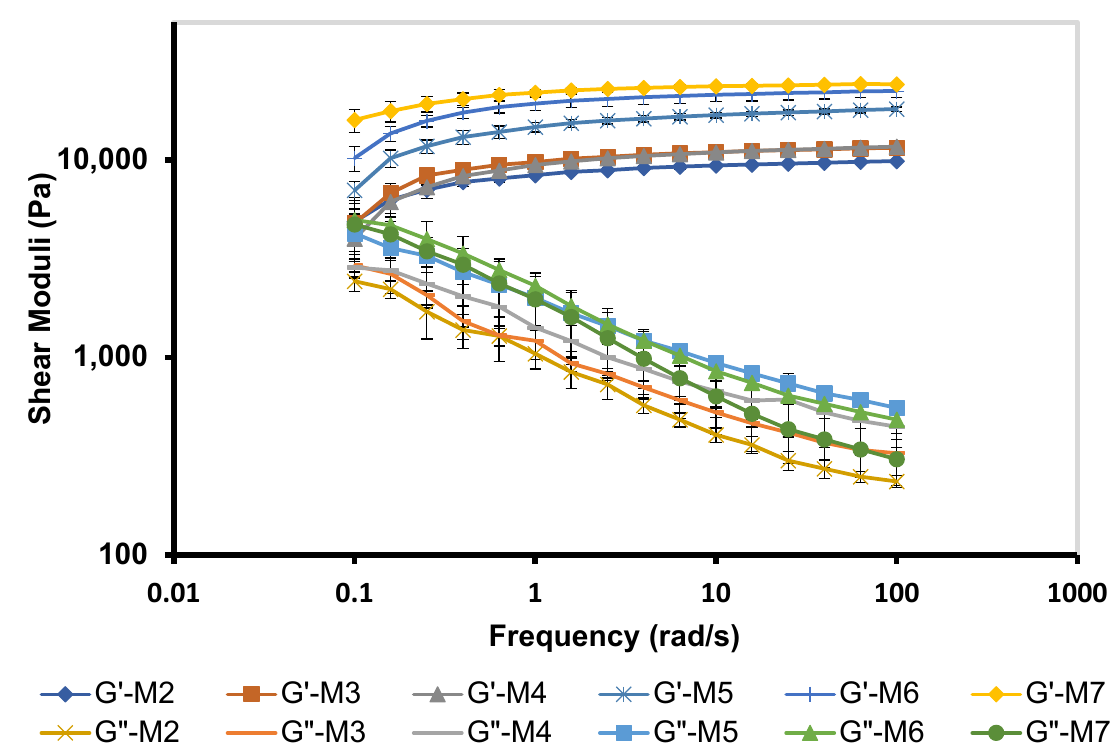
Figure 6. Frequency-dependent elastic (G ′ ) and viscous (G ″ ) moduli of M 2-7 microgels over a frequency range of 0.1–100 rad/s.